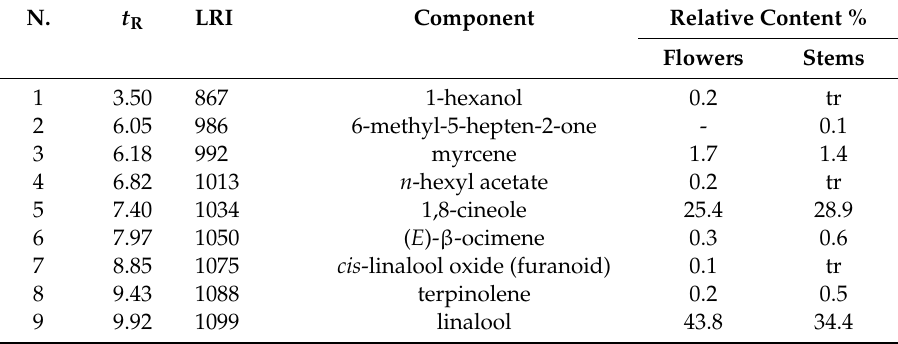
Table 1. Chemical composition (%) of Lavandin flowers and stem aromatic waters by HeadSpace,